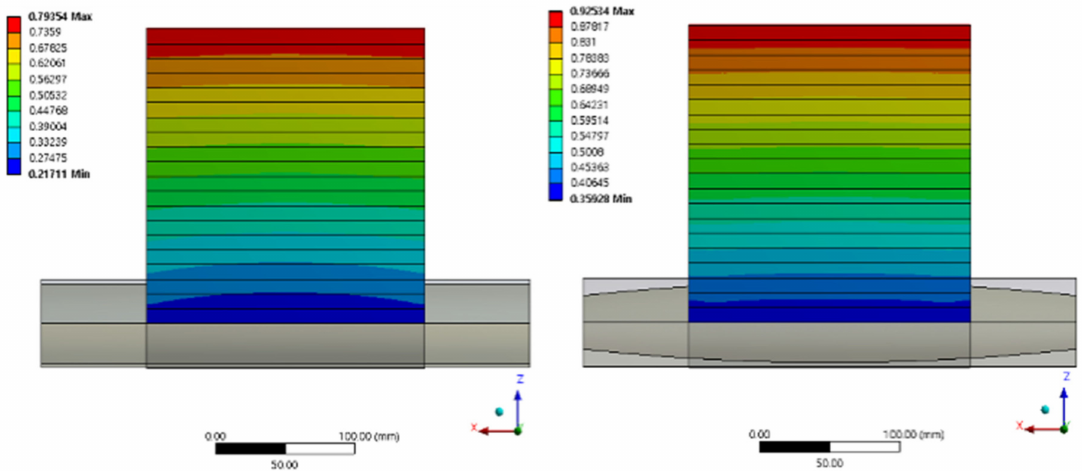
Figure 12. Comparison of total deformation results: Conventional versus optimized barrel